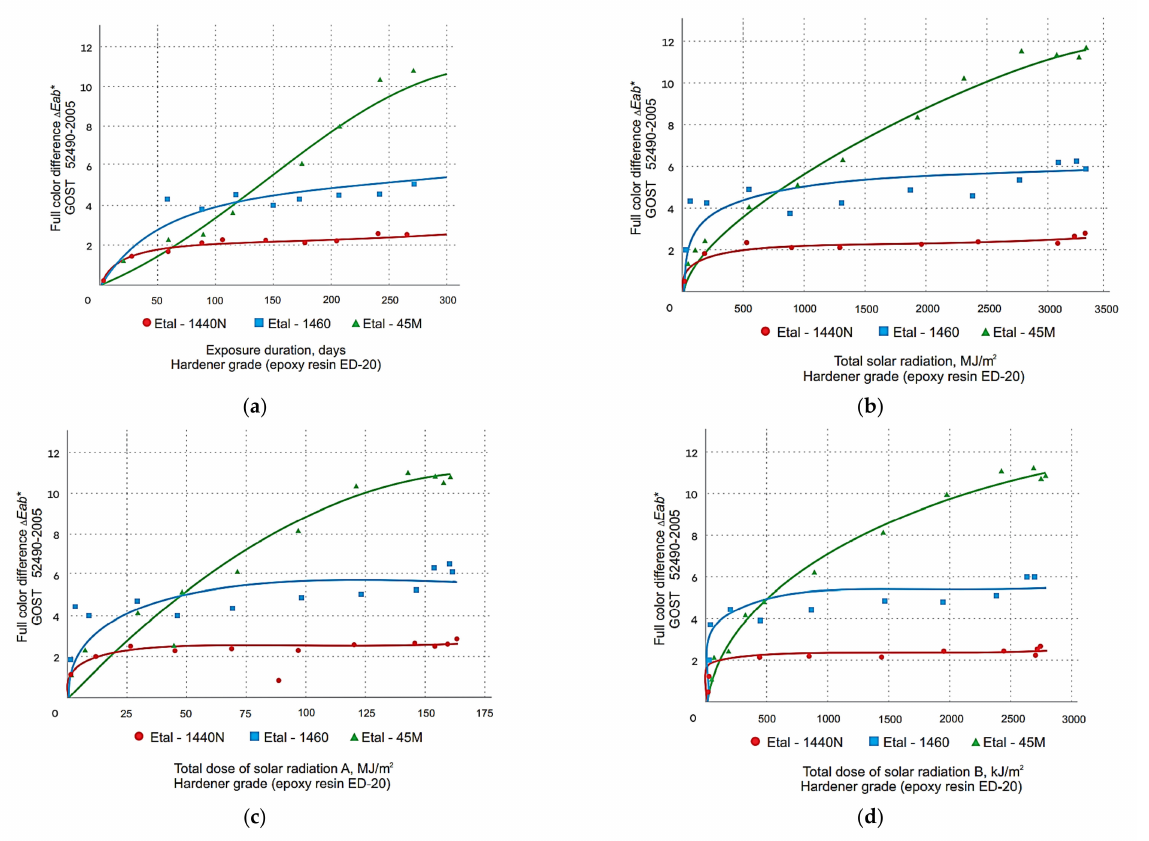
Figure 1. Change in the total color difference of polymers based on epoxy resin ED-20 depending on the duration of exposure ( a ), total solar radiation ( b ), total ultraviolet radiation of the range A ( c ) and B ( d ) when exposed to climatic